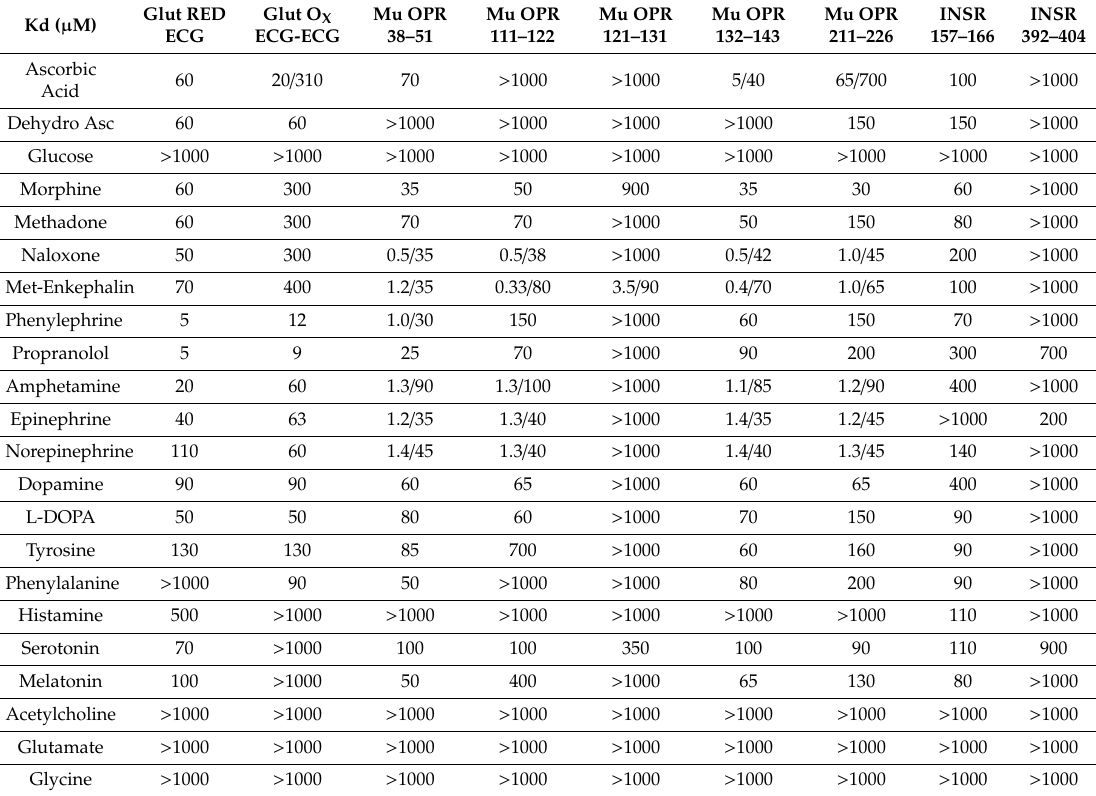
Figure 2. Binding of opioid drugs, ascorbic acid, and dehydroascorbic acid to reduced glutathione. Table 1. Summary of ultraviolet spectroscopy studies of the binding of various compounds to peptides: Glut RED = reduced glutathione; Glut Ox = oxidized glutathione; Mu OPR = mu opioid receptor; INSR = insulin receptor; Dehydro Asc = dehydroascorbic acid; L-DOPA = L-3,4- dihydroxyphenylalanine.